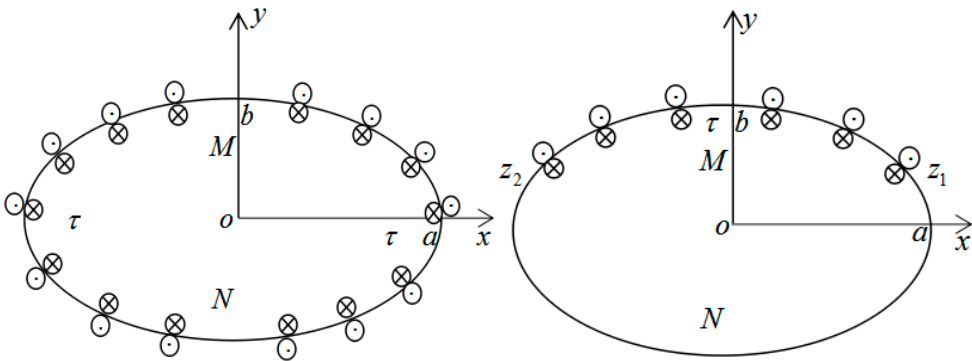
Figure 1. An elliptic notch in an anti-plane quasicrystal.